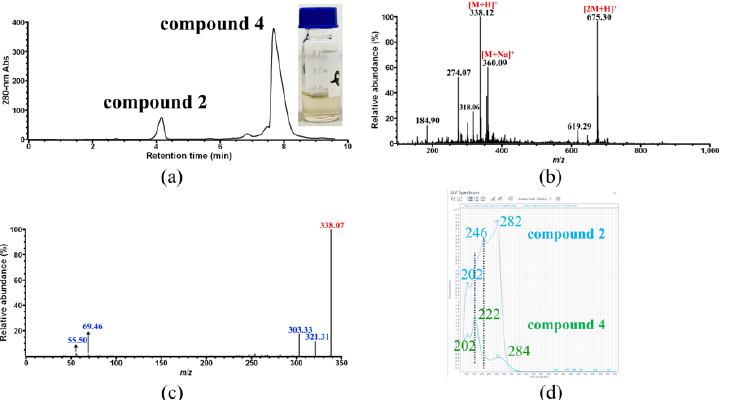
Figure 5. Identification of CP compound 4. ( a ) HPLC analysis and photo of the concentrated sample of compound 4; ( b ) MS analysis of the concentrated sample of compound 4; ( c ) MS/MS analysis of the ion with m/z 383.12 obtained in ( b ); ( d ) Overlay UV ‐ vis spectrum of the concentrated sample of compounds 2 and 4.